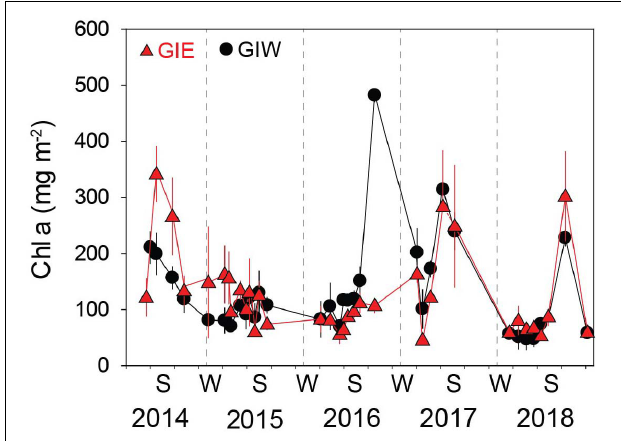
FIGURE 5 | Chlorophyll a (Chl a) in the 0–5 mm surface soil at Gyldensteen Coastal Lagoon from April 2014 to December 2018. Lines and symbols in red represent station GIE and in black represent station GIW. Results are given as average ± se ( n = 3).